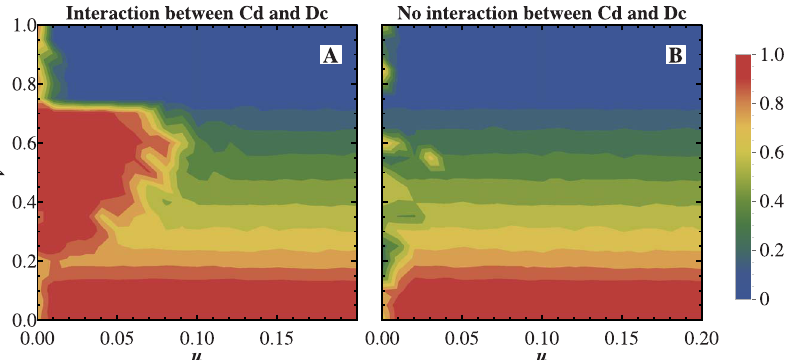
Figure 9. Illustration of the effect of roles reciprocity of Cd and Dc with p ~ 0 : 1 in u { v parameter plane. A) The fraction of Cd z Dc with the interaction between Cd and Dc . The cross domain of Cd and Dc obviously exists. B) The fraction of Cd z Dc without the interaction between Cd and Dc . The cross domain of Cd and Dc vanishes completely.